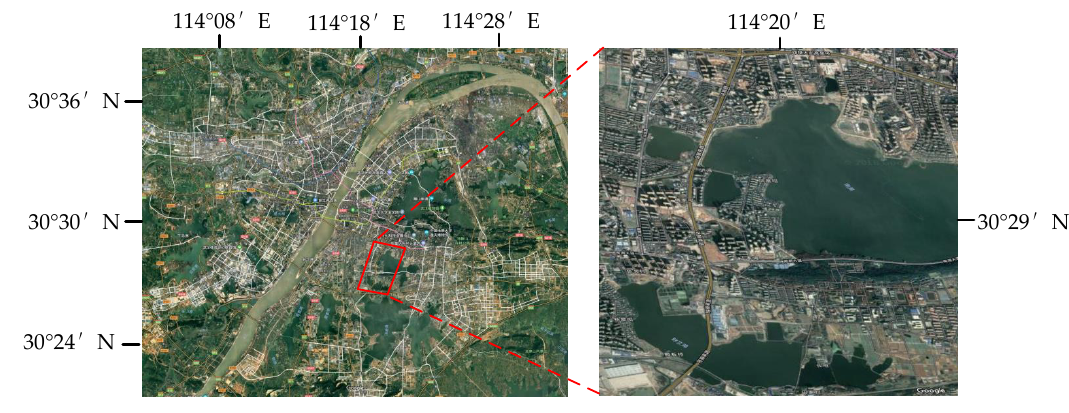
Figure 7. Optical image of